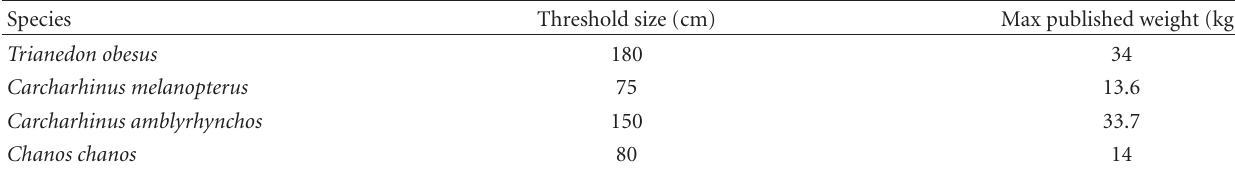
Table 2: Maximum published weights from Fishbase [30] applied to listed species sighted above the indicated threshold size. Species Threshold size